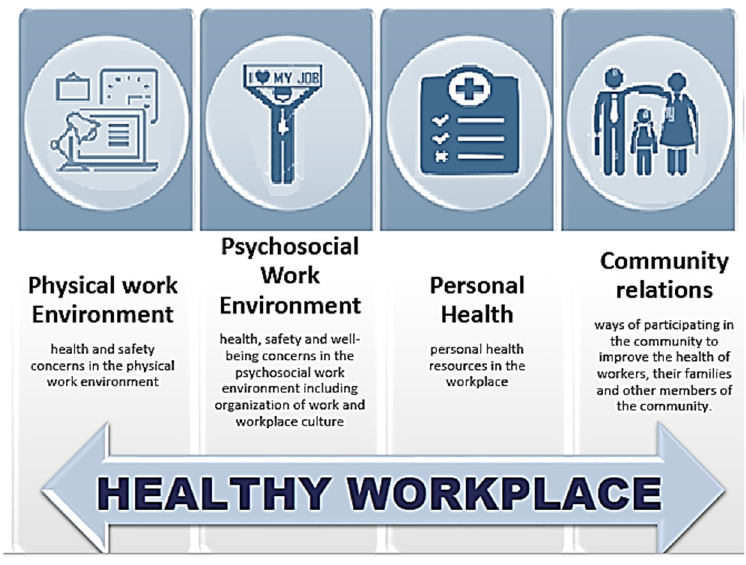
Figure 6. Identified needs concern to achieve a healthy workplace [64].